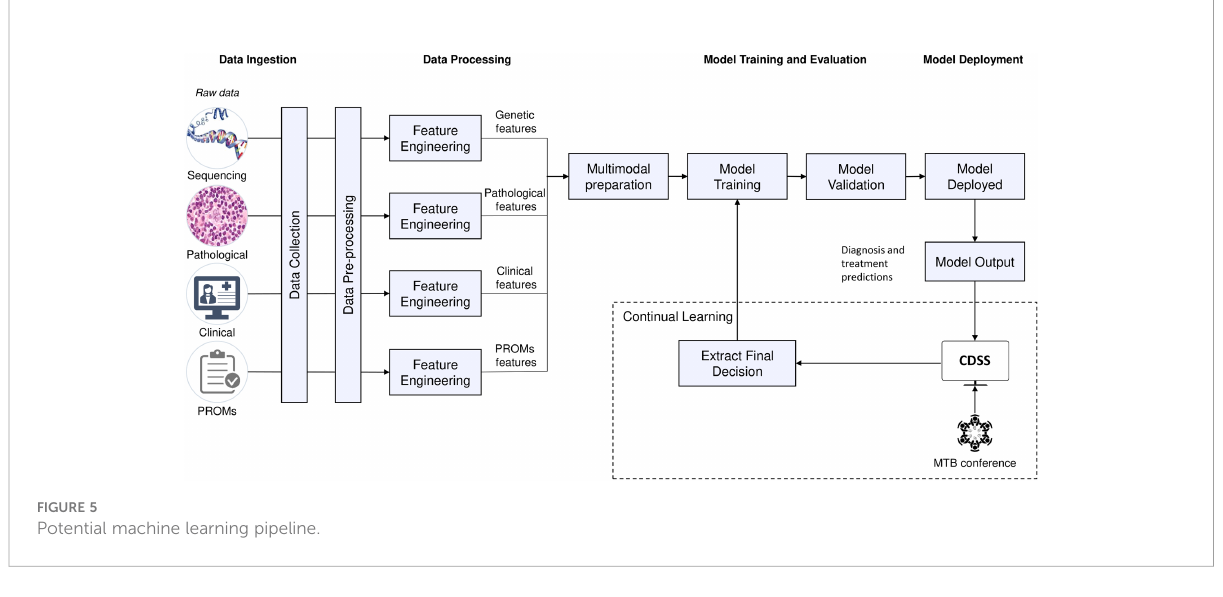
FIGURE 5 Potential machine learning